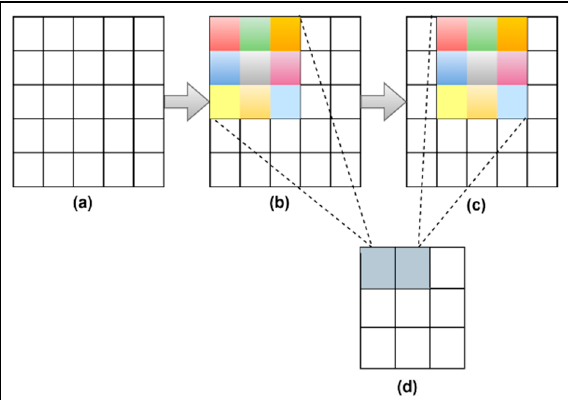
Figure 4. scaled-down example ( a ) Input image of size 5 × 5 ( b ) kernel of 3 × 3 ( c ) kernel of size 3 × 3 with stride size 1 ( d ) output image of size 3 × 3.